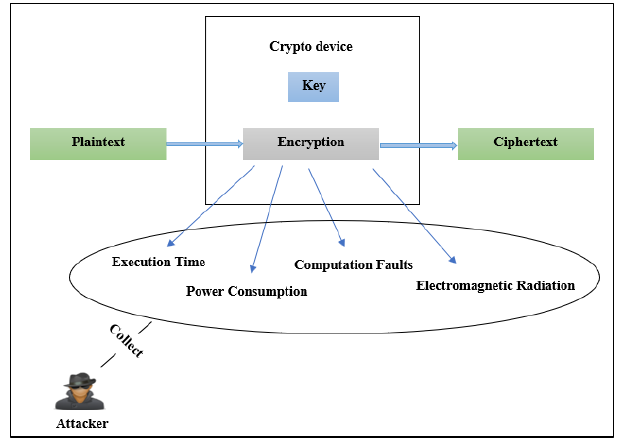
Figure 3. Side-channel